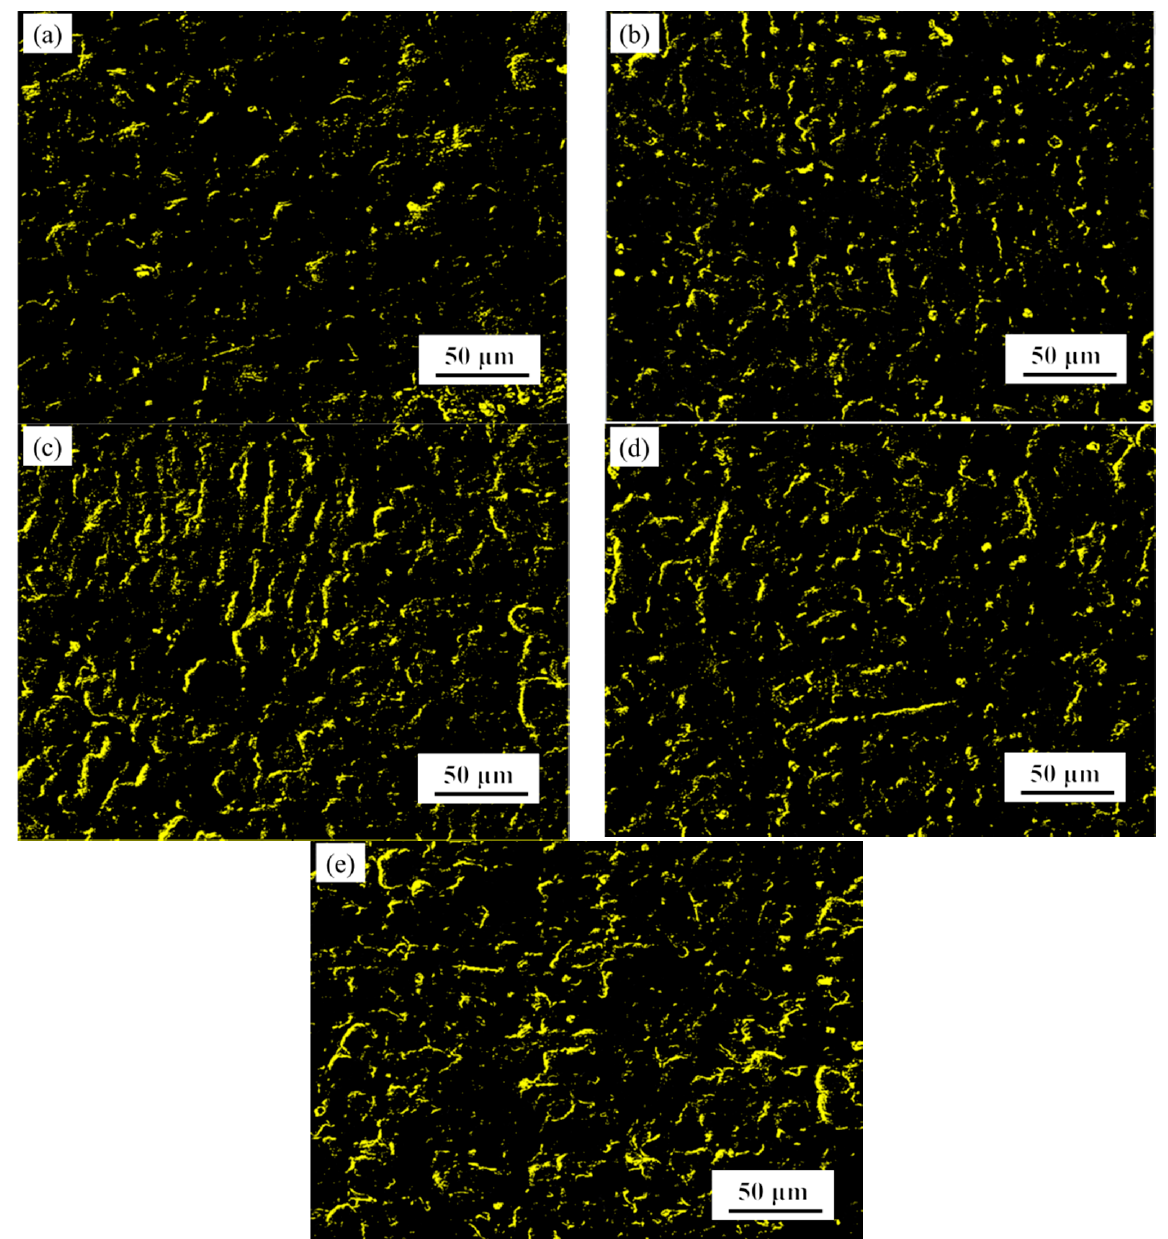
Figure 9. Surface morphology of Fe-25Mn-9Al-8Ni-1C-xTi alloy after 30 h oxidation. ( a ) 0 wt.% Ti; ( b ) 0.1 wt.% Ti; ( c ) 0.2 wt.% Ti; ( d ) 0.3 wt.% Ti; ( e ) 0.4 wt.% Ti.